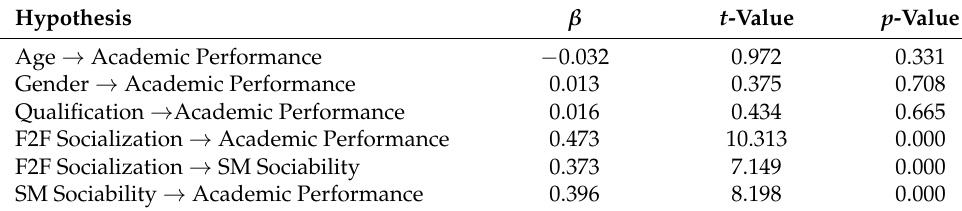
Table 9. The direct